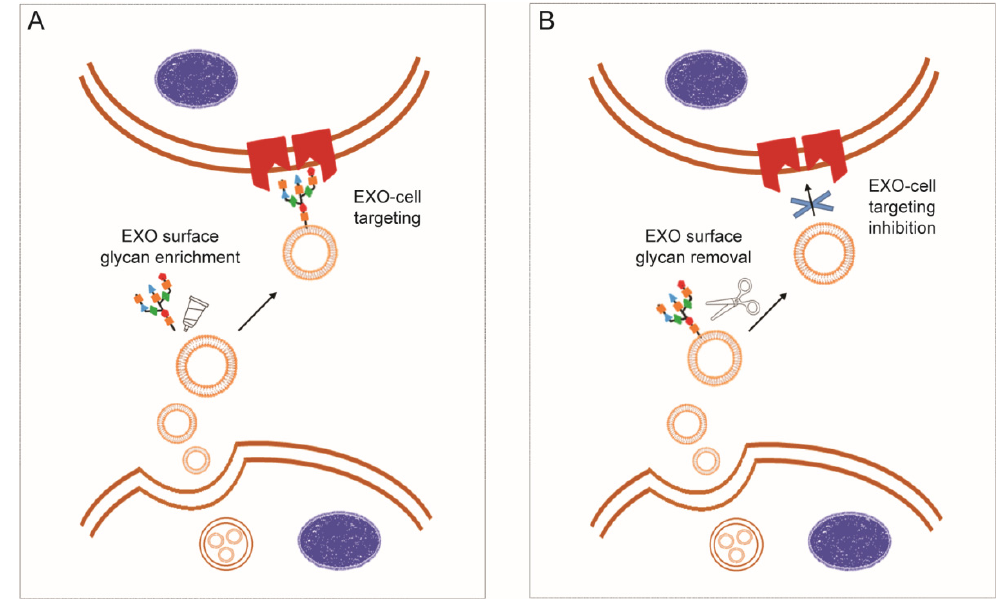
Figure 3. Sugar-based modulation of EXO surface for targeted delivery. Graphical sketch of EXO surface glycan enrichment or removal to improve panel ( A ) or limit panel ( B ) cellular recognition events [90,102–104].